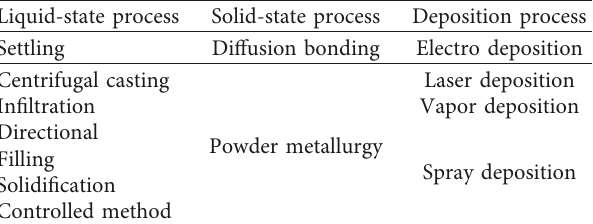
Figure 2: Representation of modern material hierarchy [16]. Table 1: Fabrication methods of FGM